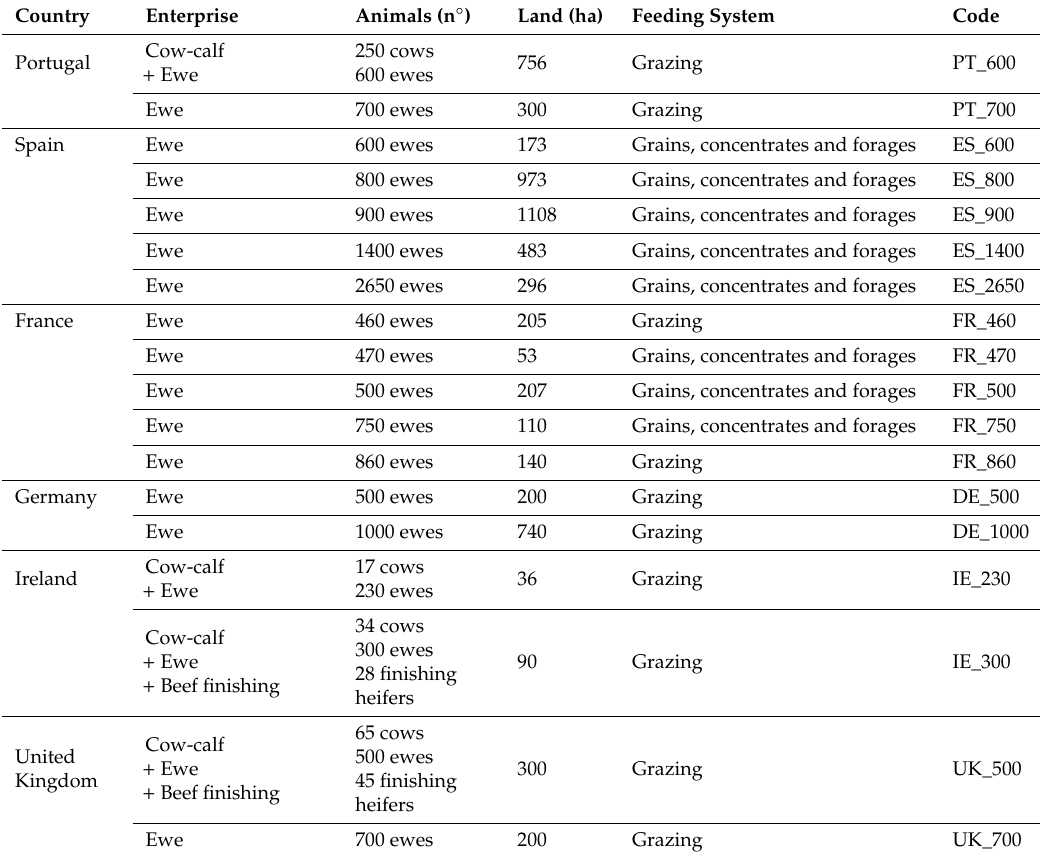
Figure 1. EU and UK ewe farms on the agri benchmark database. Table 1. EU and UK ewe farms’ main